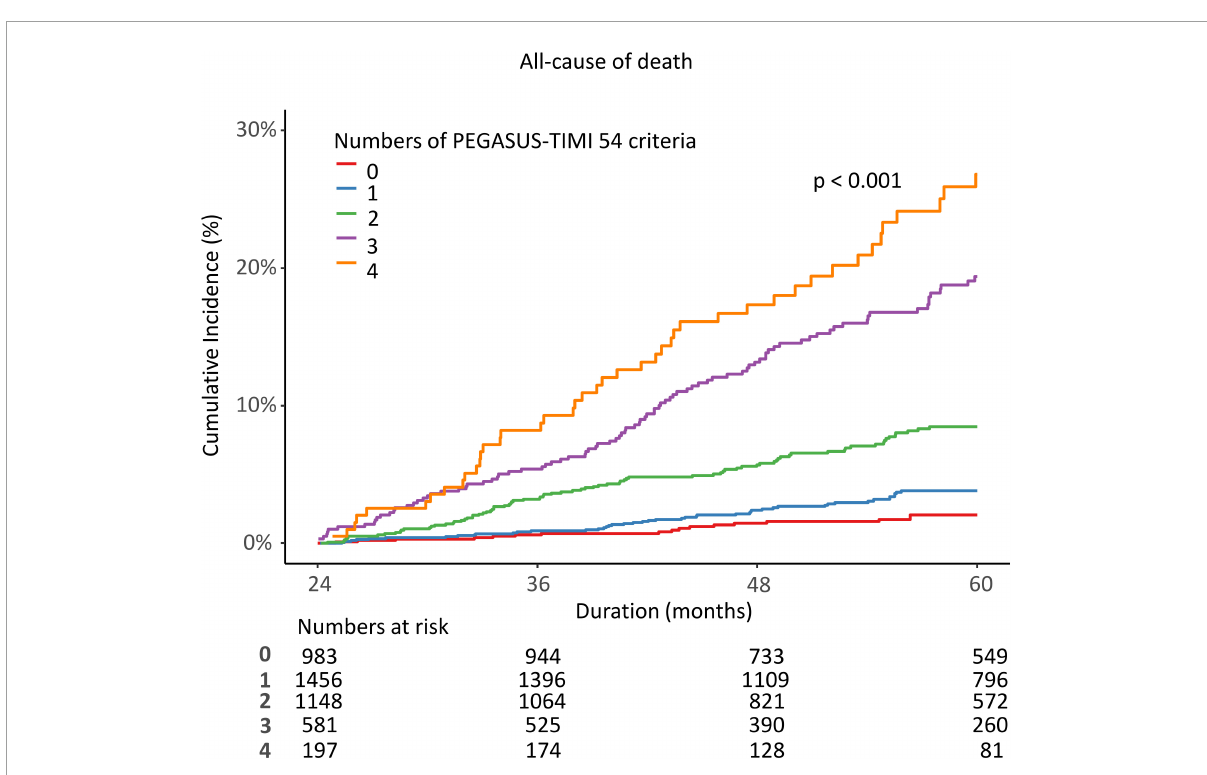
FIGURE3 K-M curve comparison according to the number of PEGASUS-TIMI 54